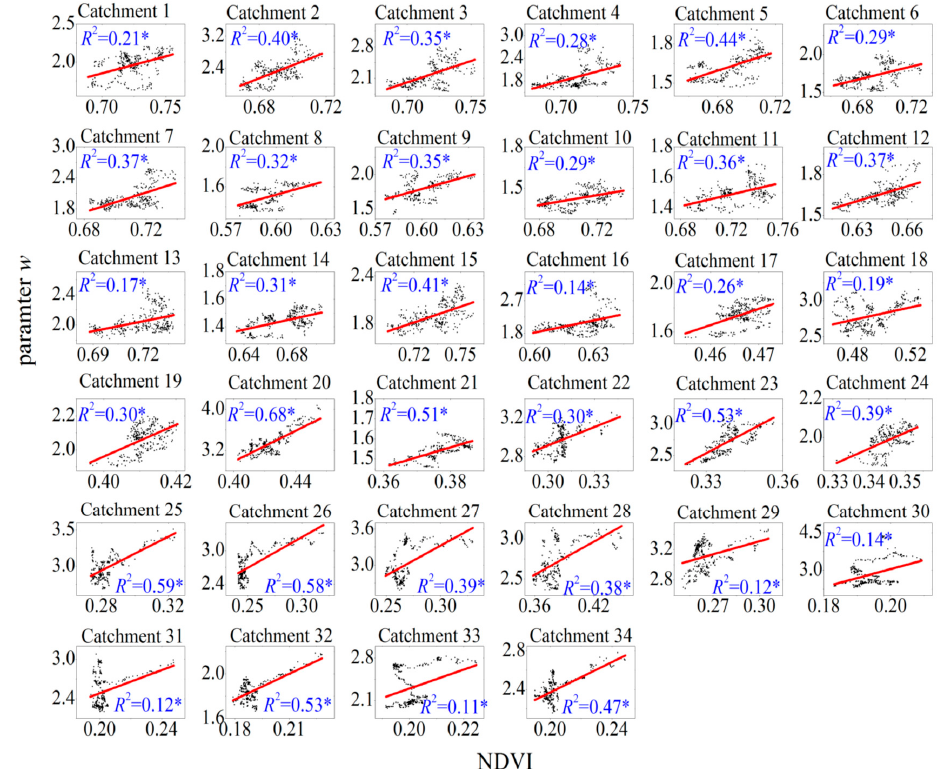
Figure 2. Relationships between NDVI and the land-surface parameter w in the 34 catchments. The red line is the fitting curve of scatters, and * indicates that the relationship is significant at the level of 0.01 by the t -test. NDVI: normalized difference vegetation index. Table 3. Relationship between NDVI and the land surface parameter w. Catchment